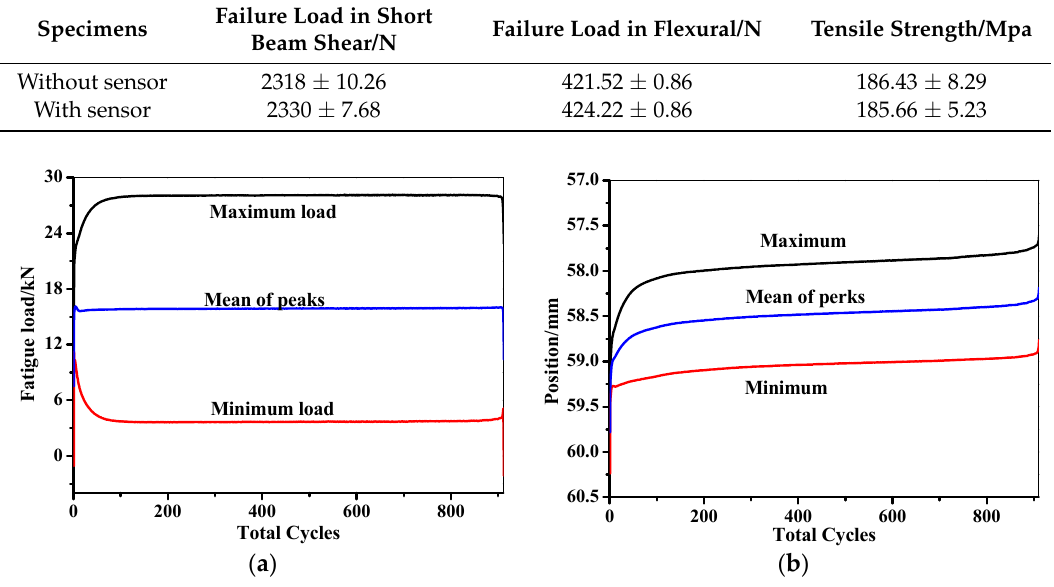
Figure 9. Parameters in the fatigue test. ( a ) Fatigue load–cycles. ( b ) Fatigue position–cycles.